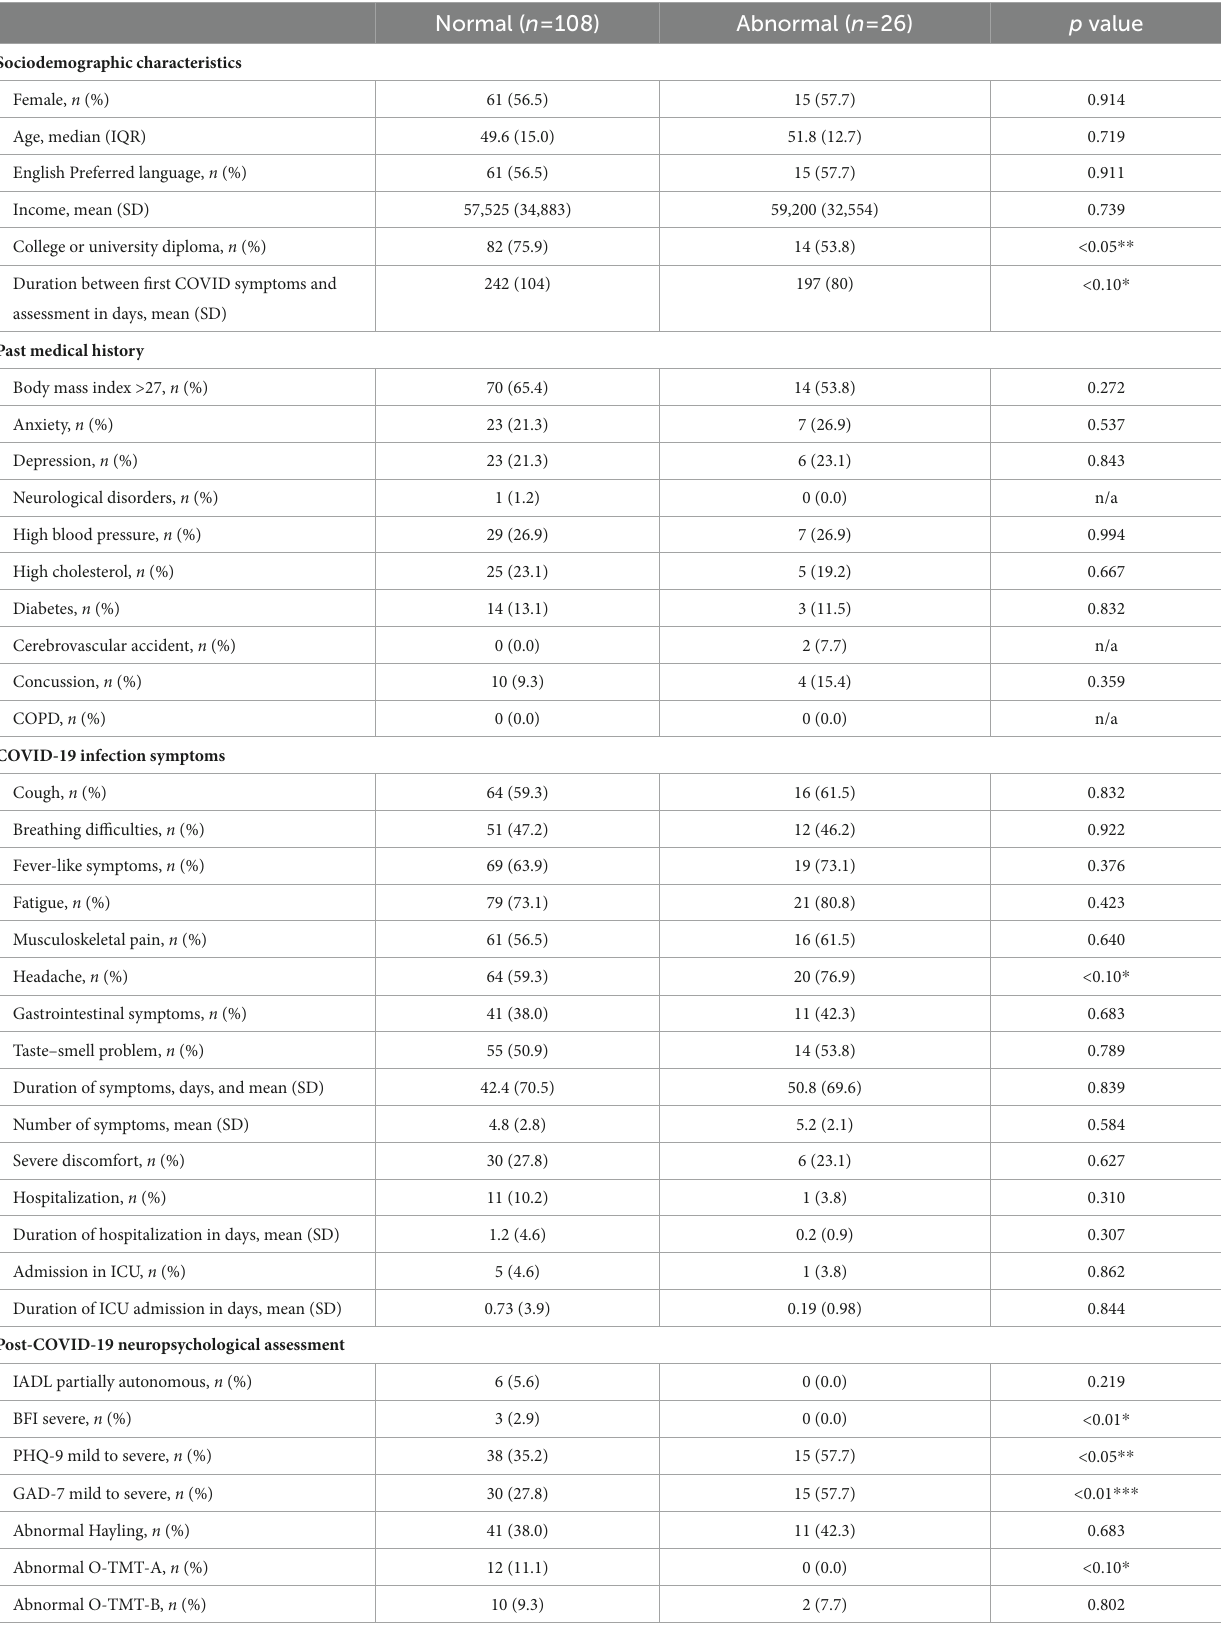
TABLE 5 Comparison of normal and pathologic m-TICS test groups. Normal ( n = 108) Abnormal ( n = 26) p